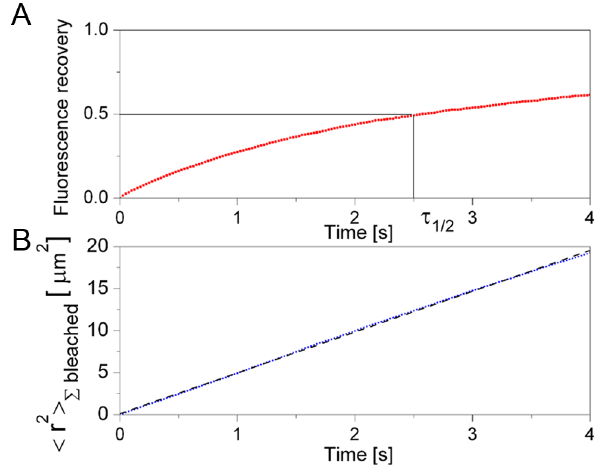
Figure 3. Simulated FRAP-like experiment. A : Recovery of relative fluorescence, F R , given by Eq. (14) (shown in red), obtained from the simulated FRAP experiment depicted in Video 0.3. For the initial conditions of the simulation (a totally bleached spherical volume of radius R FRAP ) the half recovery time, t 1 = 2 , ( i.e. the time at which F R ~ 1 = 2 ) is related to the diffusion coefficient by D FRAP & R 2 FRAP . From 9 : 98 t 1 = 2 the simulation we obtain t 1 = 2 & 2 : 575s . Using R FRAP ~ 4 m m we derive D FRAP & : 62 m m 2 = s . B : Single molecule MSD , S r 2 T S BLEACHED , computed using Eq. (11) for the bleached particles, as a function of time (shown in blue) and linear fit (shown in black). The slope of the fitting curve is 4 : 8 m m 2 = s which yields an estimated diffusion coefficient of & : 8 m m 2 = s